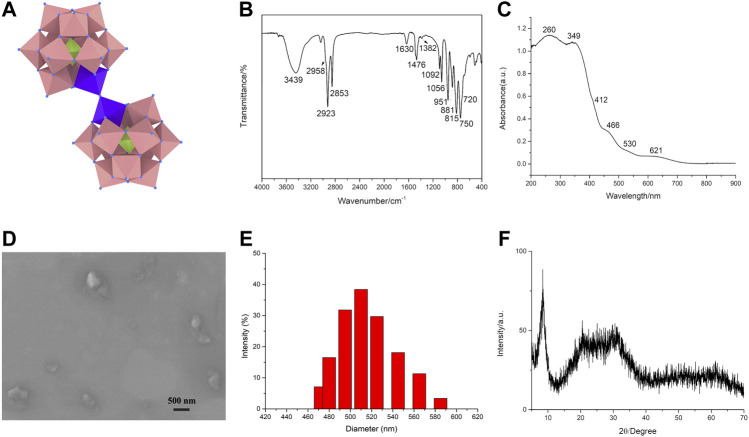
The structure and characterization of the dimeric Keggin-type phosphotungstate. The structure of ODA10[(PW11Fe)2] (A). IR spectrum (B), UV-vis DRS (C), SEM image (D), DLS characterization (E), and XRD pattern (F) of ODA10[(PW11Fe)2].